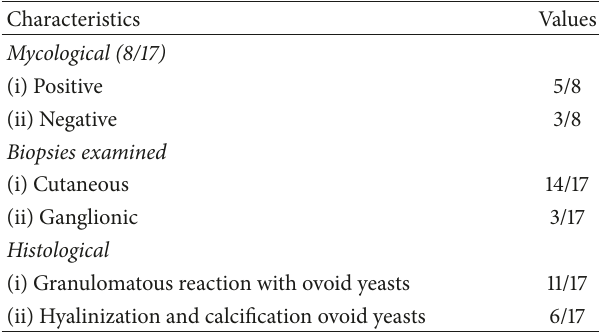
Table 2: Pathologic characteristics of